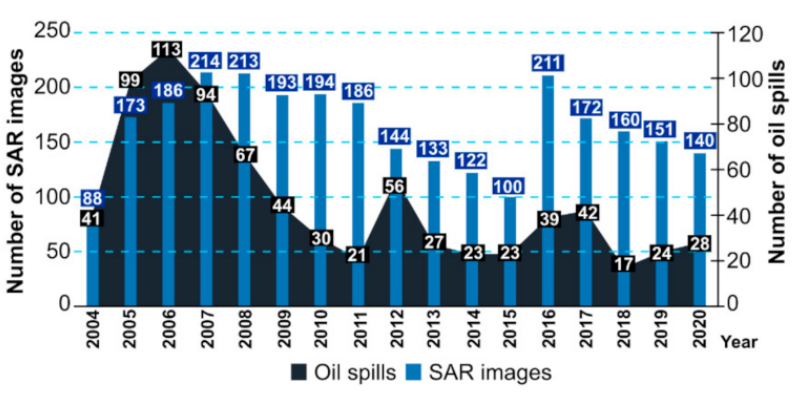
Figure 7. Interannual variability of the analyzed number of SAR images and detected oil spills in 2004–2020.